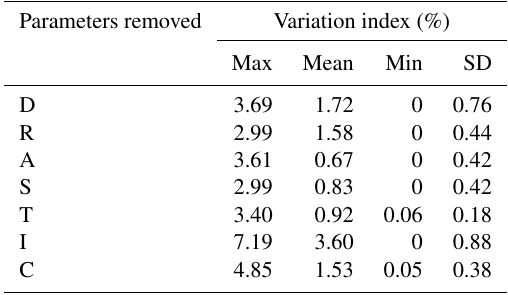
Table 10. Map removal sensitivity analysis (one parameter is re- moved at time).